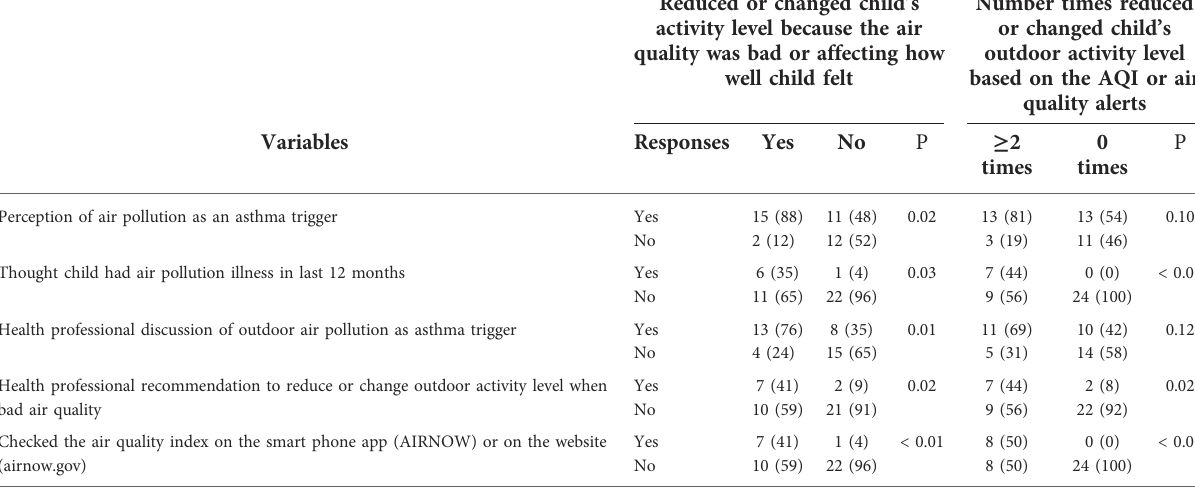
TABLE 3 Analysis of select variables and reported outdoor activity modi fi cations based on air quality in children with persistent